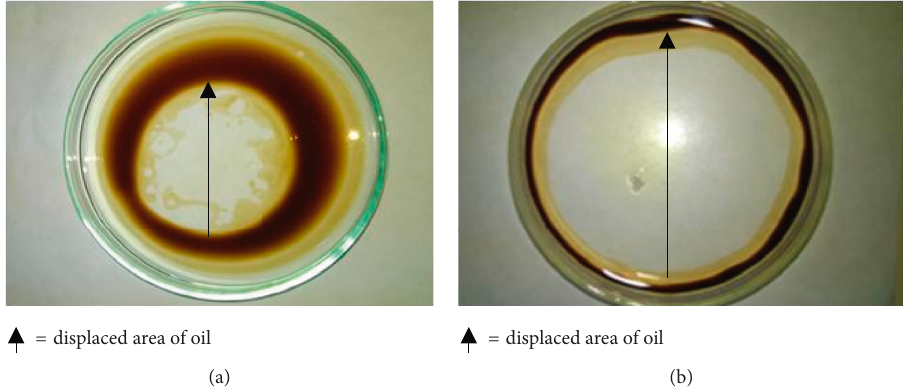
Figure 2: Dispersion test of petroderivatives in water evaluated by oil displacement area (ODA): (a) oil and biosurfactant of Cunninghamella echinulata ; (b) oil and chemical surfactant